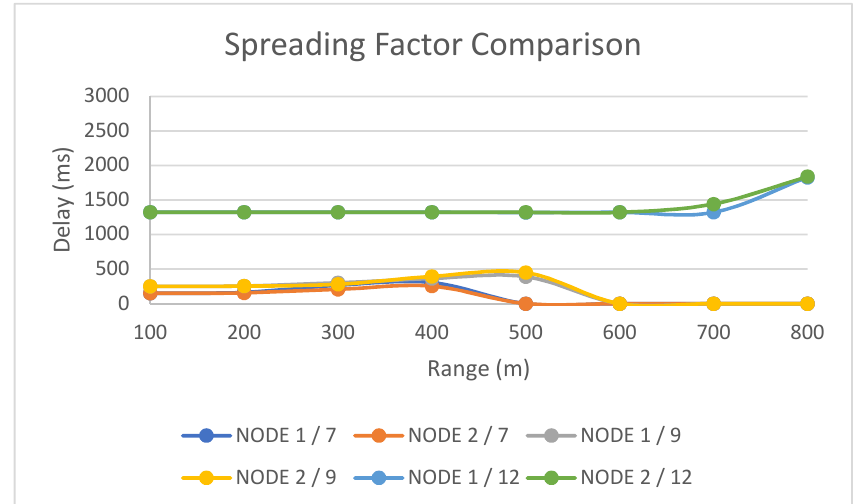
Figure 11. The delay graph from the reassessment of several spreading factors.